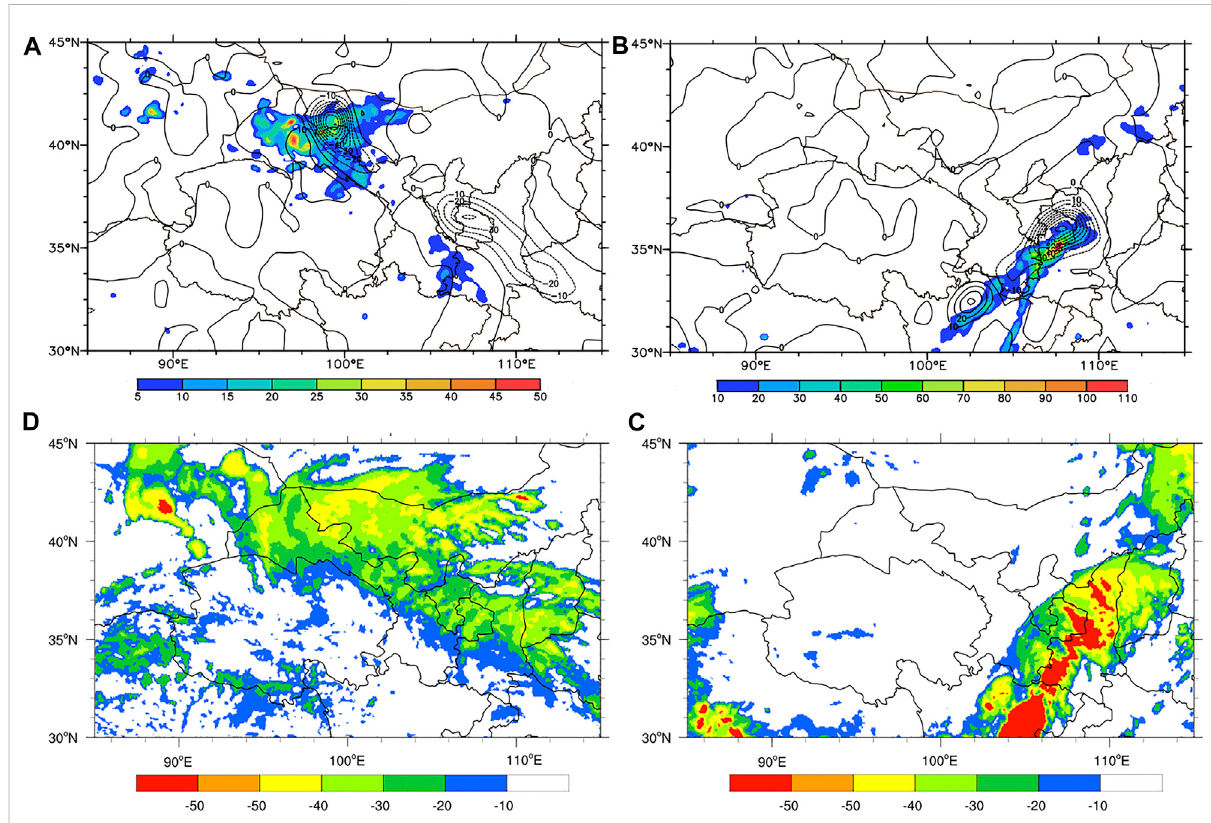
FIGURE 8 The moisture helicity (Unit: 10 – 11 m s − 3 ) on 500 hPa and 6-h accumulated precipitation (Unit: mm) (A,B) , black-body temperature (TBB) by FY- 2E satellite (C,D) at 06: 00 5 June 2012 in Case 2012 (A,C) and at 12: 00 21 July 2013 in Case 2013 (B,D) .